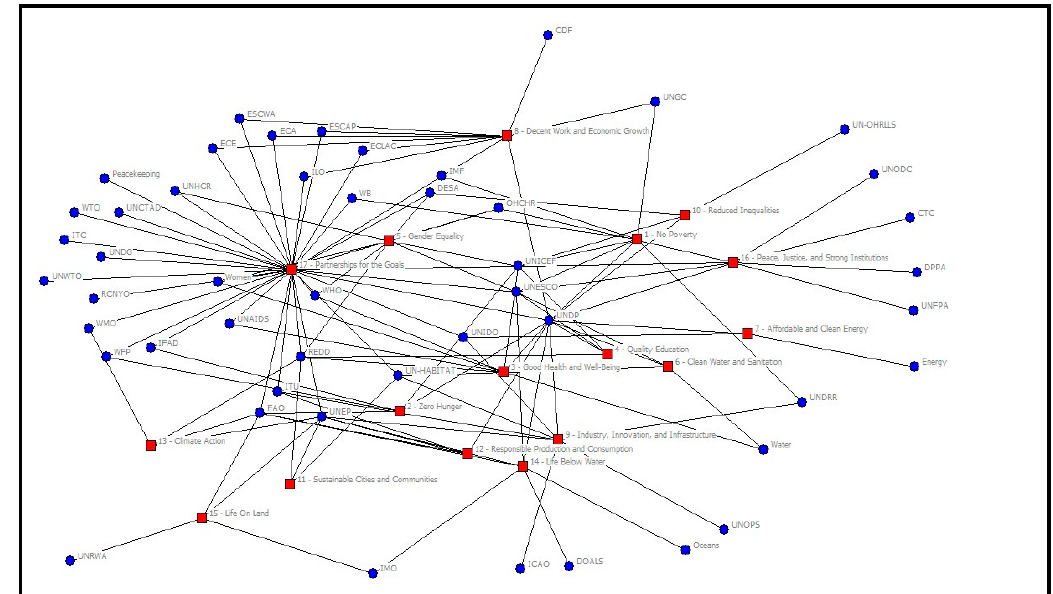
Figure 4. Sustainable Development Goals (SDGs)—whole network.